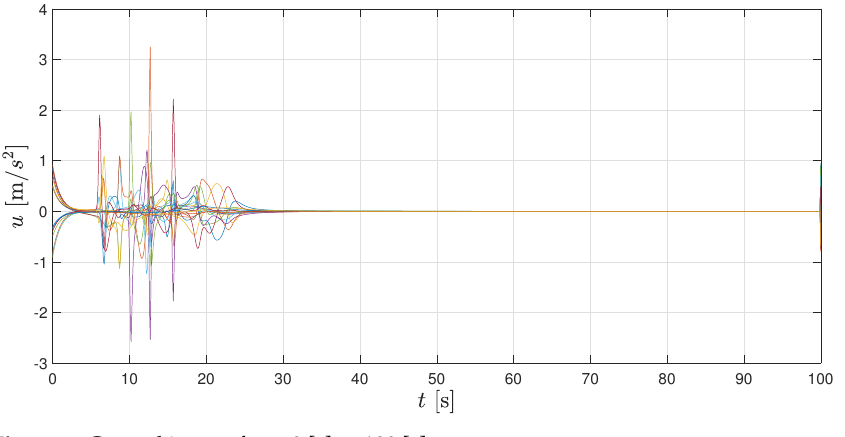
Figure 8. Control inputs from 0 [s] to 100 [s].